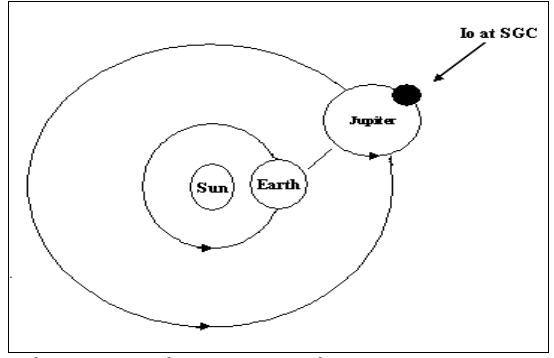
Fig.1: Explains how the CML Io's phase are measured with respect to the observer on Earth [1].